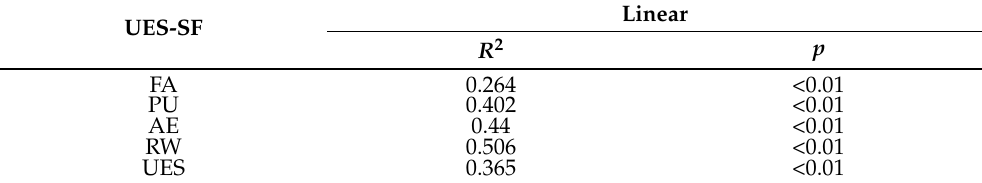
Table 11. Maximum R 2 values for categorical regression quantified by assigning idealized numerical values for each engagement